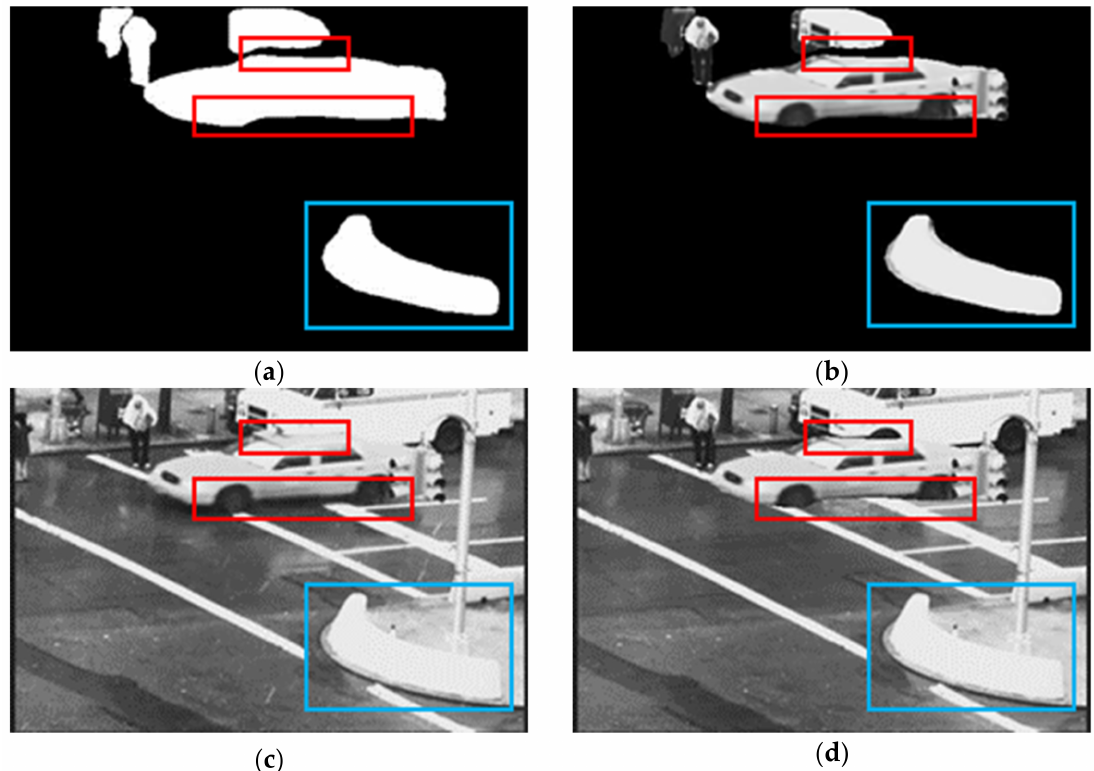
Figure 8. The output of the Mask R-CNN model-based process of the video sequence “Traffic”, frame 79. Red rectangle area indicates missing area of moving objects and the blue rectangle area indicates the false detection of Mask R-CNN. ( a ) Mask R-CNN Object mask ( b ) Segmented objects. ( c ) Input frame 79 and ( d ) Generated rain-free image by Mask